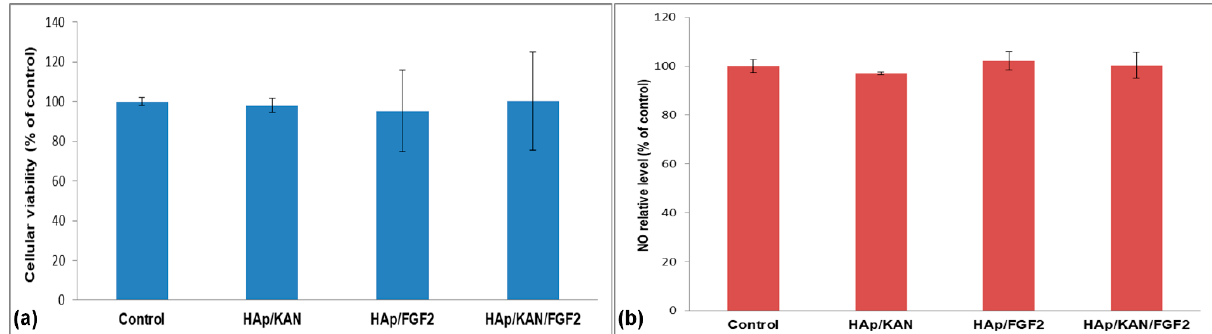
Figure 6. MTT cellular viability ( a ) and NO release ( b ) of osteoblastic cells cultured for 24 h on control and Ti modified with HAp/KAN, HAp/FGF2, and HAp/KAN/FGF2 coatings ( n = 3)